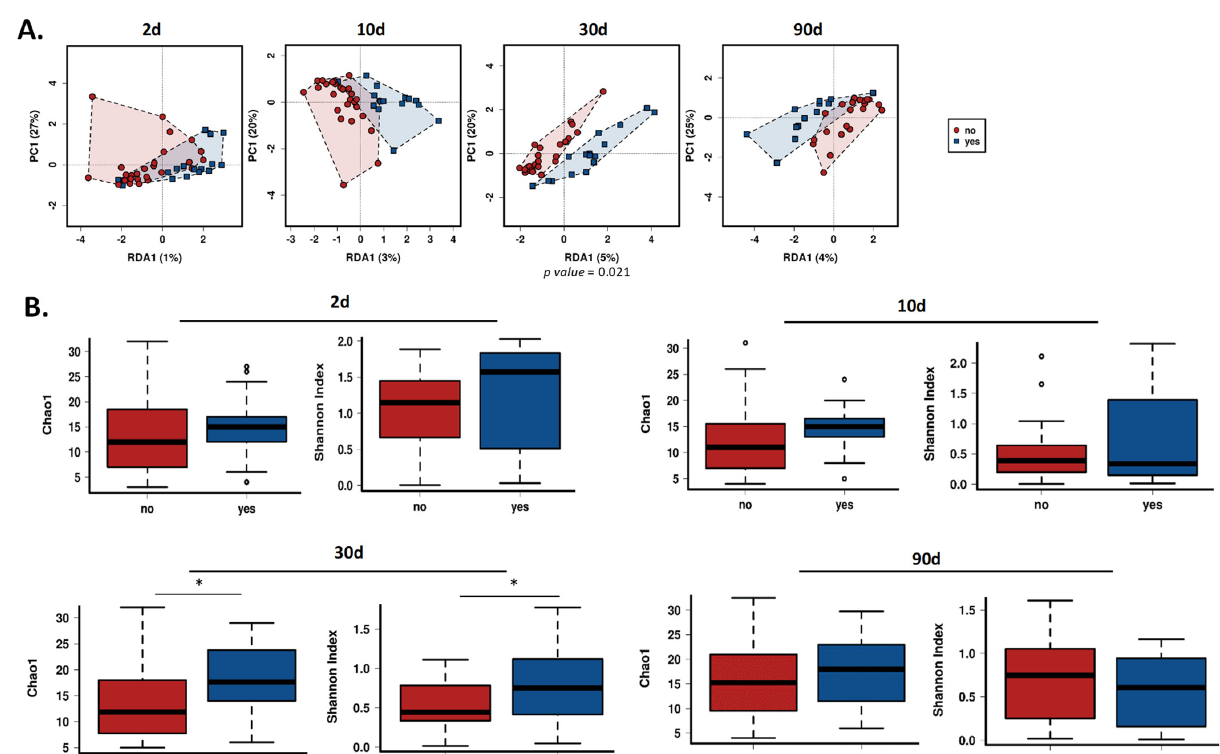
Figure 1. Gut bifidobacterial diversity. ( A ) Redundancy analysis (RDA) and ( B ) Chao1 and Shannon indexes between the control and antibiotic group of babies at 2, 10, 30 and 90 days of life. No: Control group (non-antibiotic); Yes: Antibiotic group. * Indicates statistically significant differences ( p < 0.05).